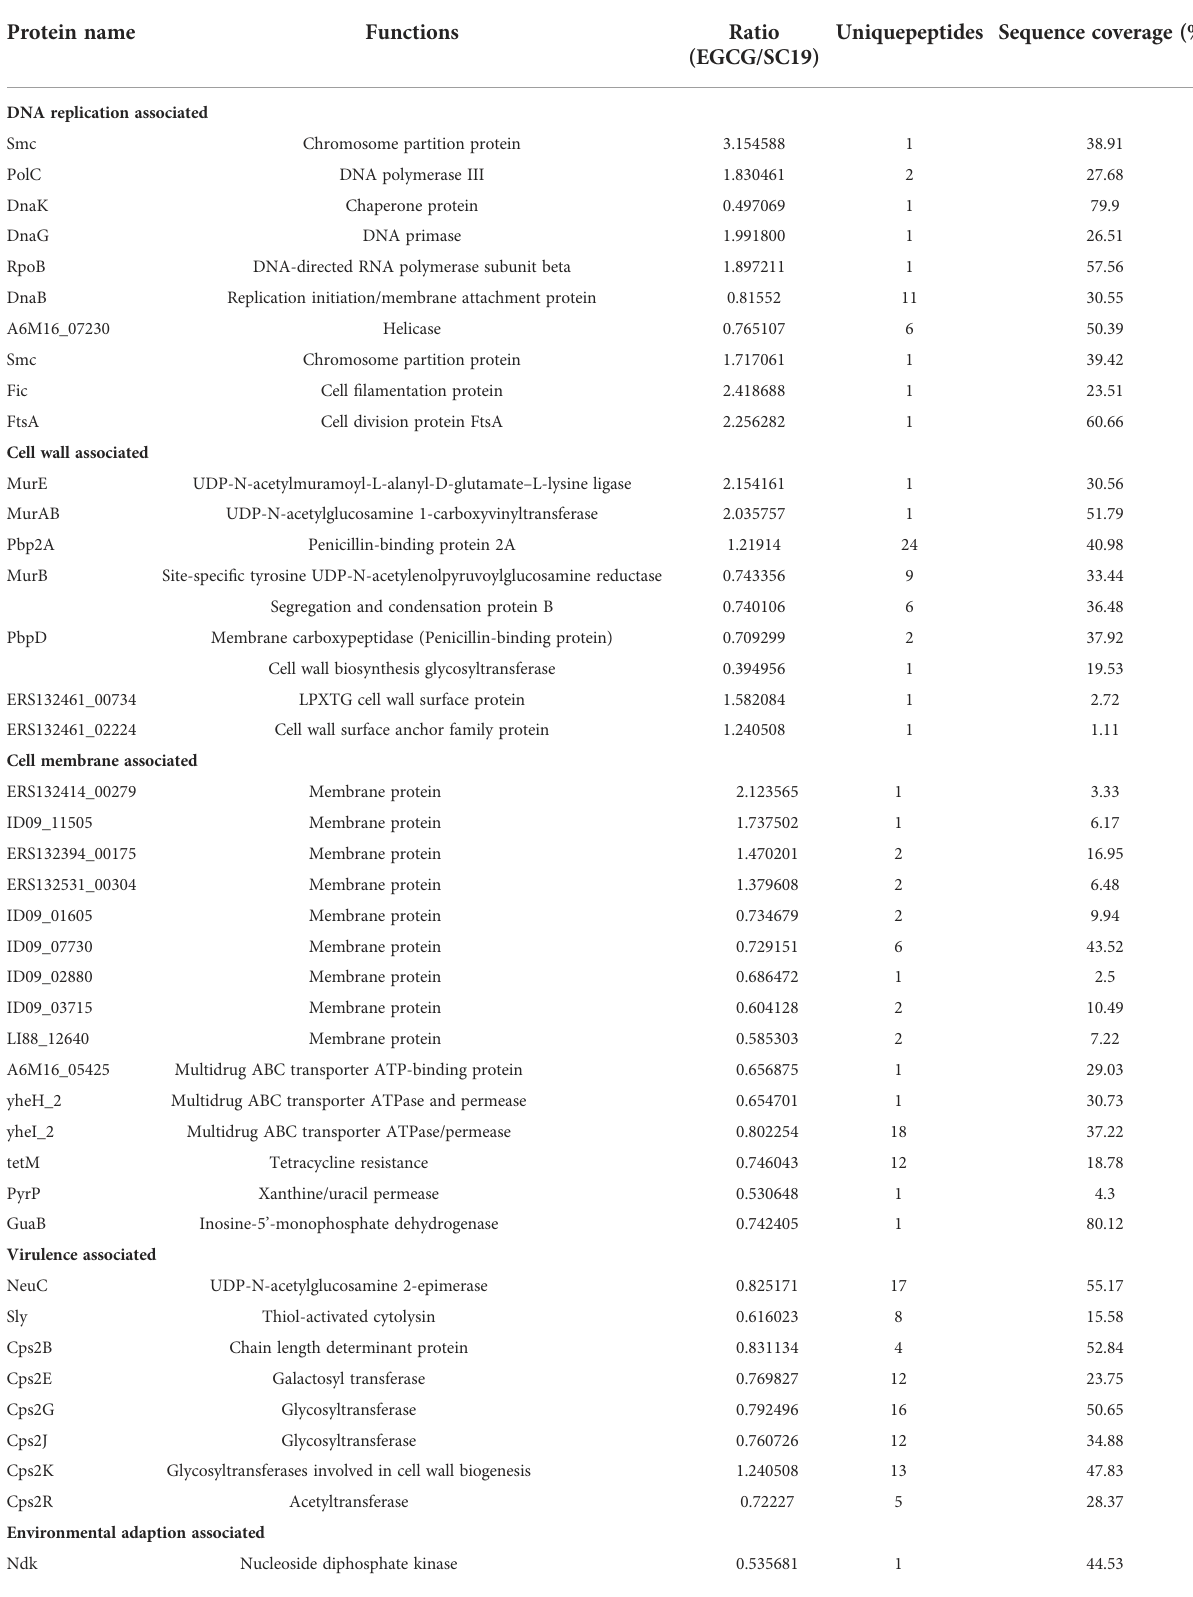
TABLE 2 List of the identi fi ed DEPs between SC19 vs EGCG treated SC19. Protein